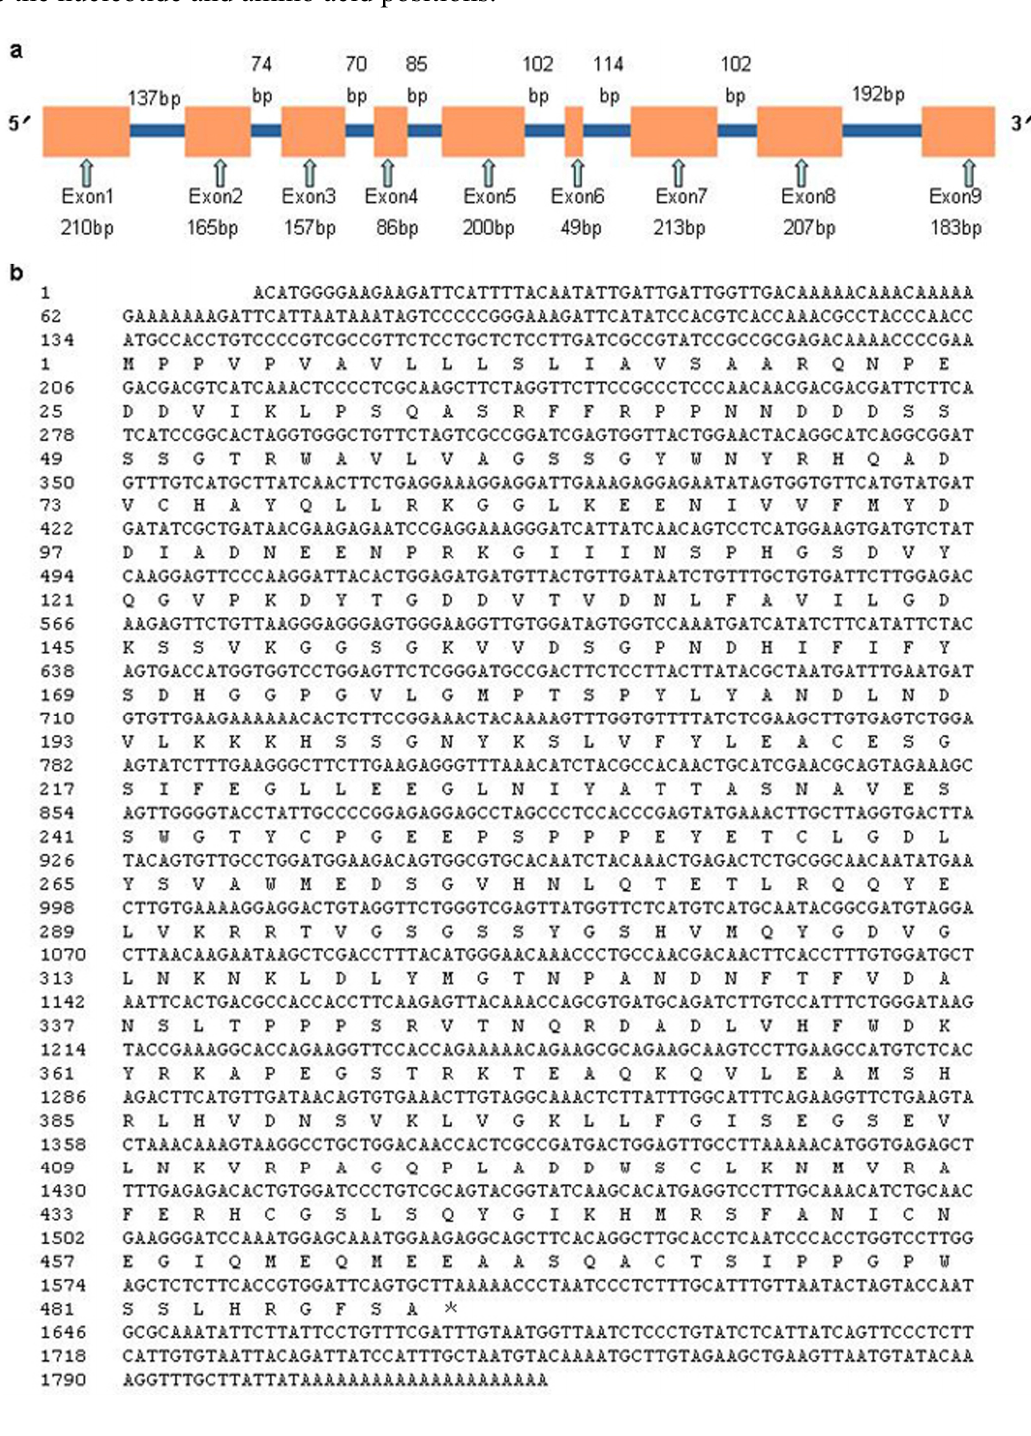
Figure 2. Schematic diagram and nucleotide sequence of RsVPE1 . ( a ) Schematic diagram of the genomic RsVPE1 sequence. Exons are indicated by hollow arrows followed by their names and sizes. Orange and blue boxes indicate the exons and introns, respectively; ( b ) Schematic diagram of the full-length RsVPE1 cDNA sequence. The numbers on the left are the nucleotide and amino acid